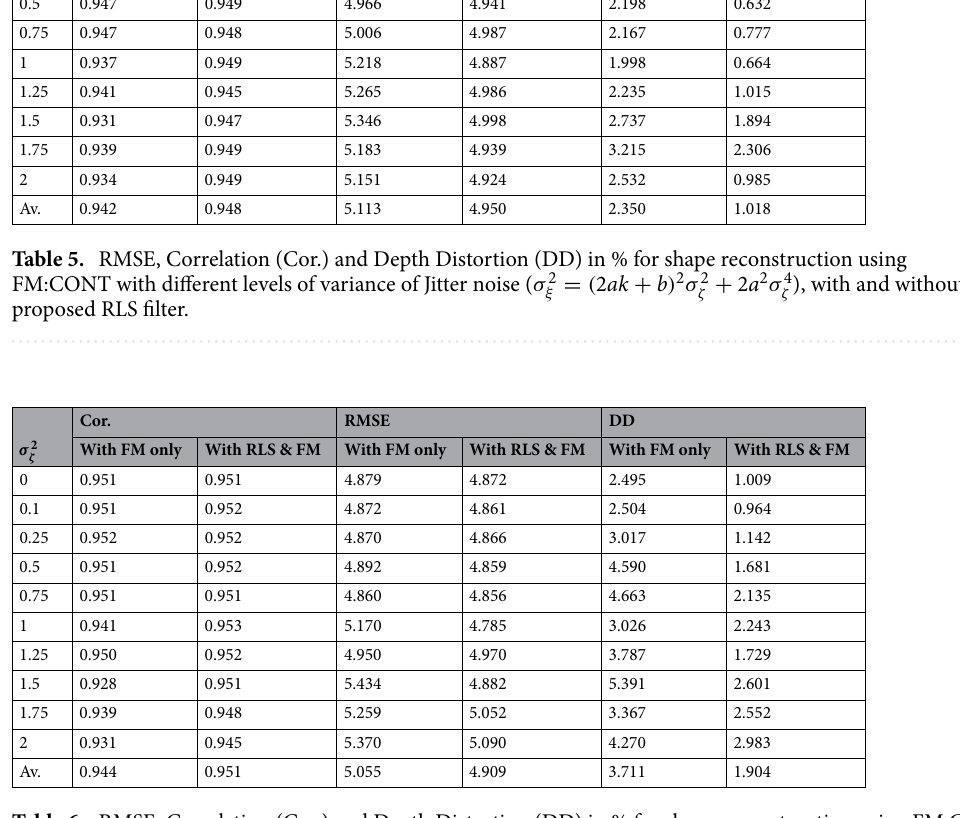
Table 6. RMSE, Correlation (Cor.) and Depth Distortion (DD) in % for shape reconstruction using FM:GLVA with different levels of variance of Jitter noise ( σ 2 ξ = ( 2 ak + b ) 2 σ 2 ζ + 2 a 2 σ 4 ζ ), with and without proposed RLS